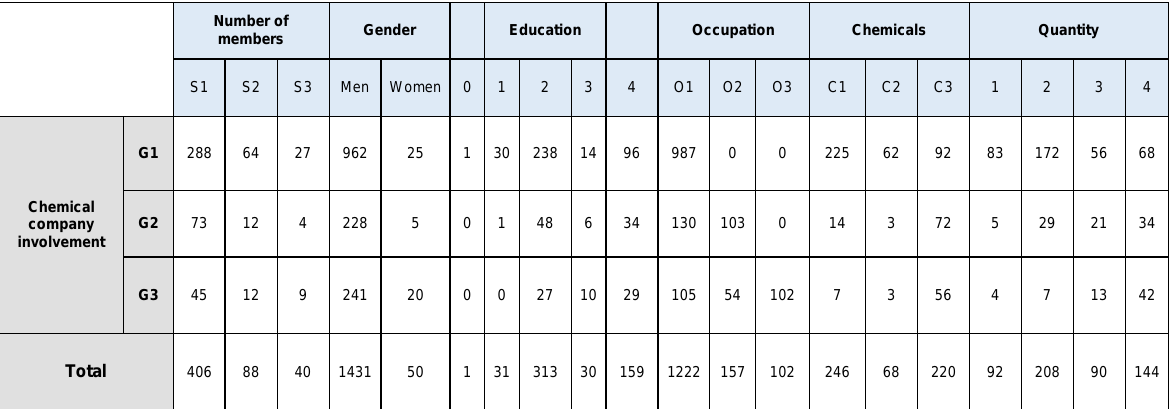
Table 2: Statistical differences between